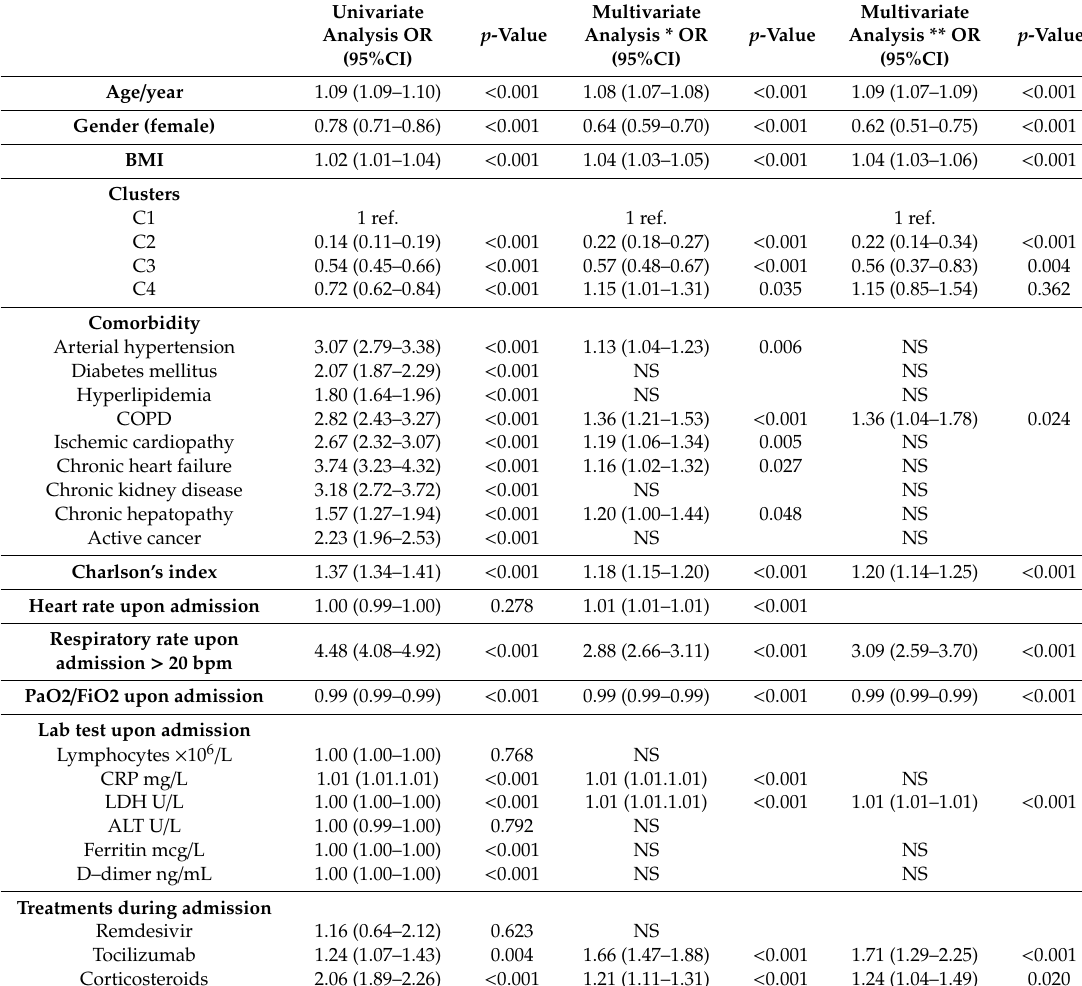
Table 6. Risk factors of in-hospital